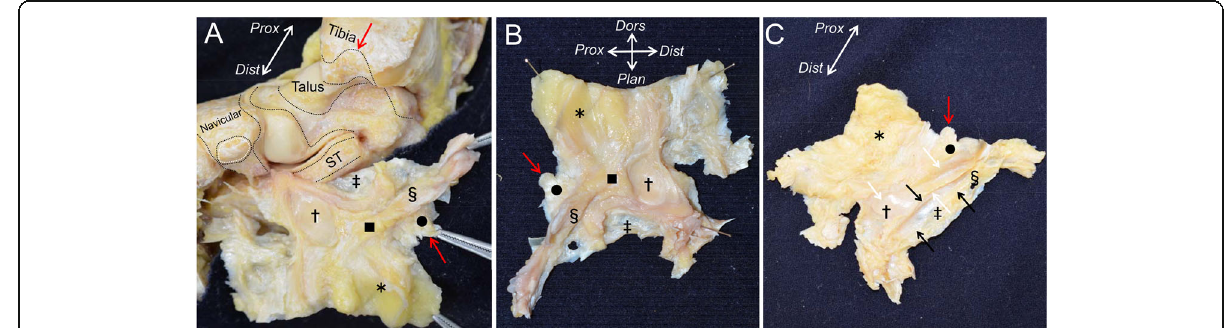
Fig. 4 Whole appearance of the joint capsule. a The whole flipped continuous capsule remaining attachment to the calcaneus is shown. The black dotted area indicates the attachment of the joint capsule. The white dotted area indicates the insertion of the posterior tibialis (PT) tendon. Red arrows indicate the corresponding bone and detached capsule. b The inner appearance of the continuous capsule is shown after being completely detached from the calcaneus. The continuous capsule consists of 3 different tissues: fatty tissue ( asterisk ), fibrous tissue ( black circle ), and cartilaginous capsule ( dagger ). The fatty tissue extended medially and attached between the fibrous and the cartilaginous tissue ( black square ). c The outer appearance of the continuous capsule. The part of the fibrous tissue ( black circle ) and the cartilaginous tissue ( dagger ) formed the sheath floor of the PT tendon ( white arrows ), and the part of the fibrous tissue ( section mark ) formed the sheath floor of the flexor digitorum longus tendon ( black arrows ). Prox, proximal; Dist, distal; Plan , plantar; Dors , dorsal; PT , insertion of the posterior tibialis tendon; Nav , navicular; ST , sustentaculum tali; double dagger, capsule corresponding to sustentaculum